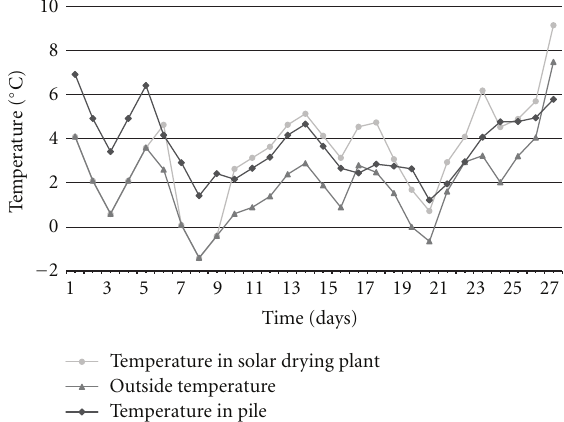
Figure 7: The course of temperature during the winter cycle (De-